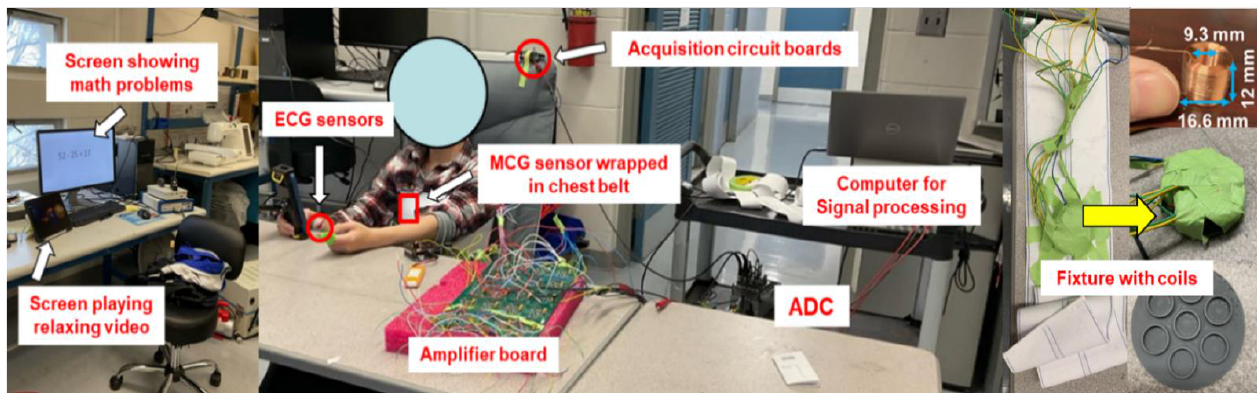
Figure 1. Experimental setup employed in this